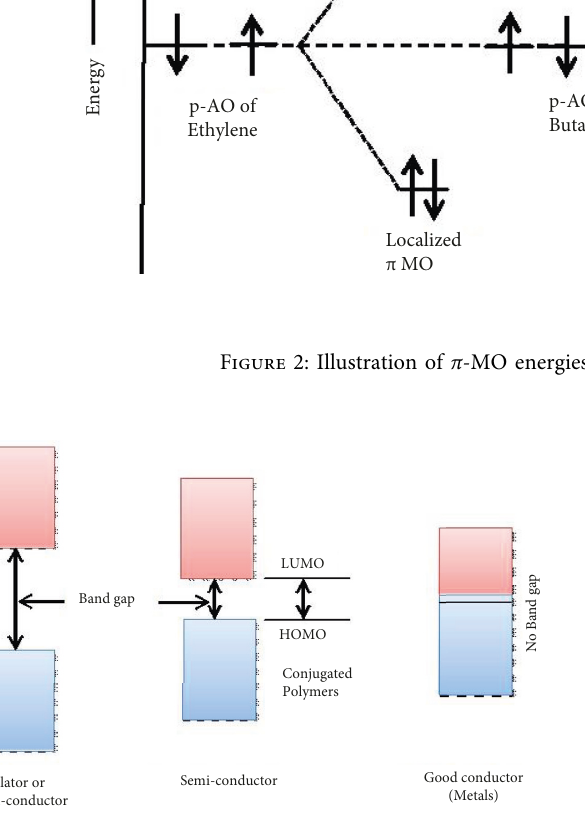
Figure 3: Band gap constructions for insulator, semiconductor, and